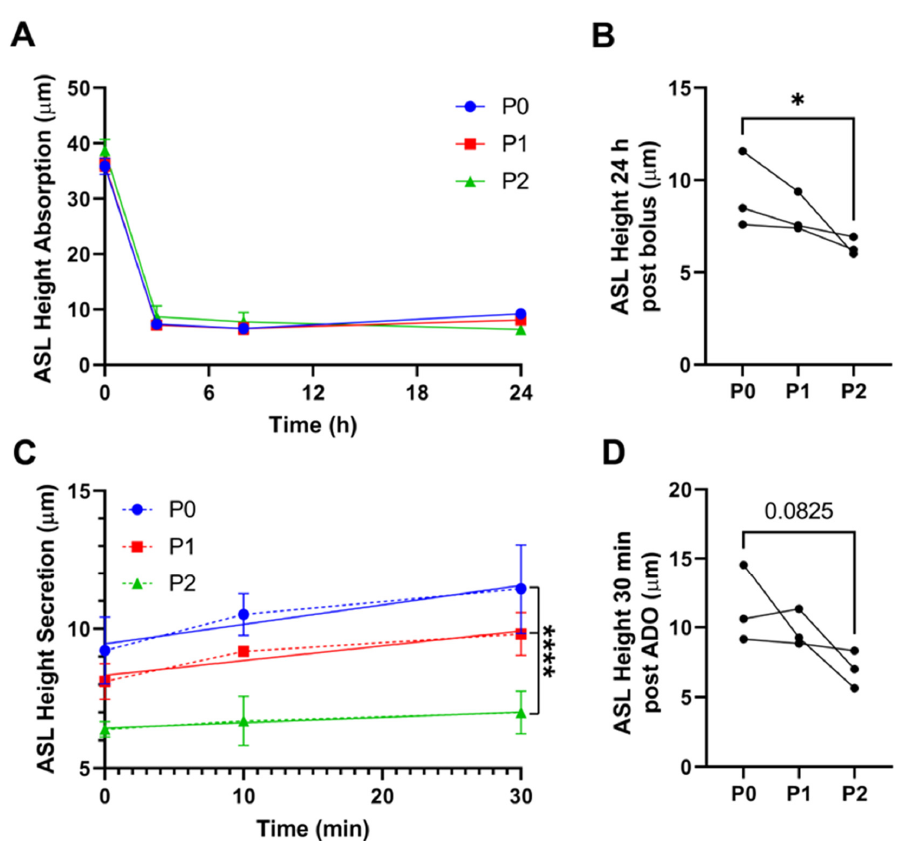
Figure 1. Passaging HBECs alters epithelial absorption and secretion dynamics. ( A ) ASL height at various timepoints after ASL was labeled with a bolus of rodamine–dextran. ( B ) ASL height 24 h after the bolus was added. ( C ) ASL height after adenosine (ADO) was added to stimulate CFTR-mediated secretion. ( D ) ASL height 30 min after adenosine was added * = p < 0.05, Friedman test. **** = p < 0.001 intercepts between fits; n = 3.